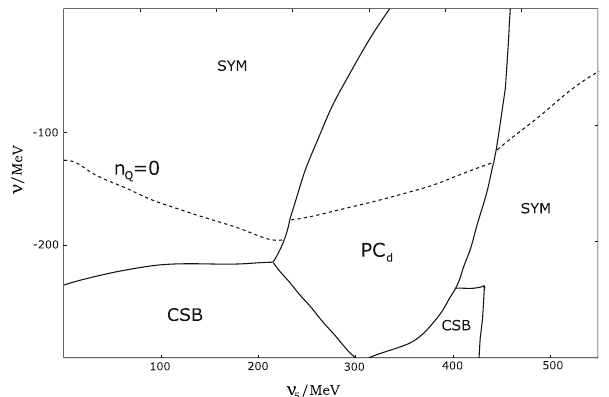
Fig. 9 The (ν 5 ,ν) -phase diagram of β -equilibrium quark matter (see the models (7), (8)) at μ = 400 MeV and μ 5 = 300 MeV in the chiral limit, m 0 = 0. All the notations are the same as in Figs. 1, 2 and 3